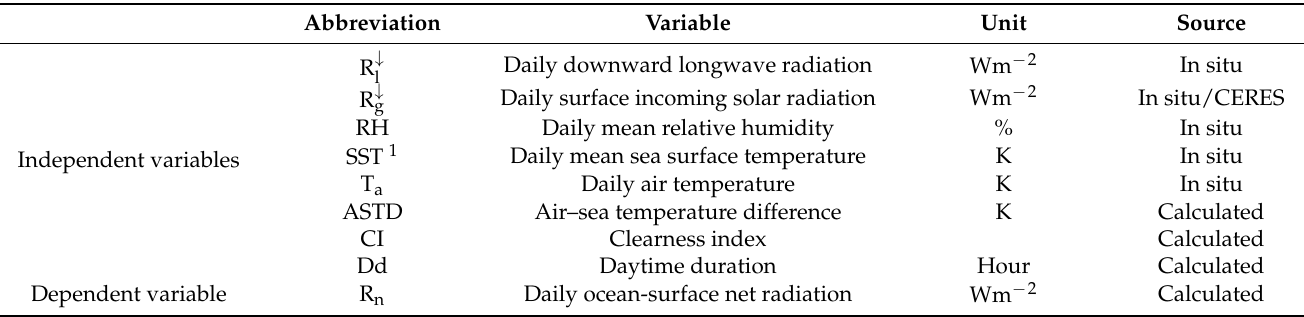
Table 1. Variables used for modeling in this